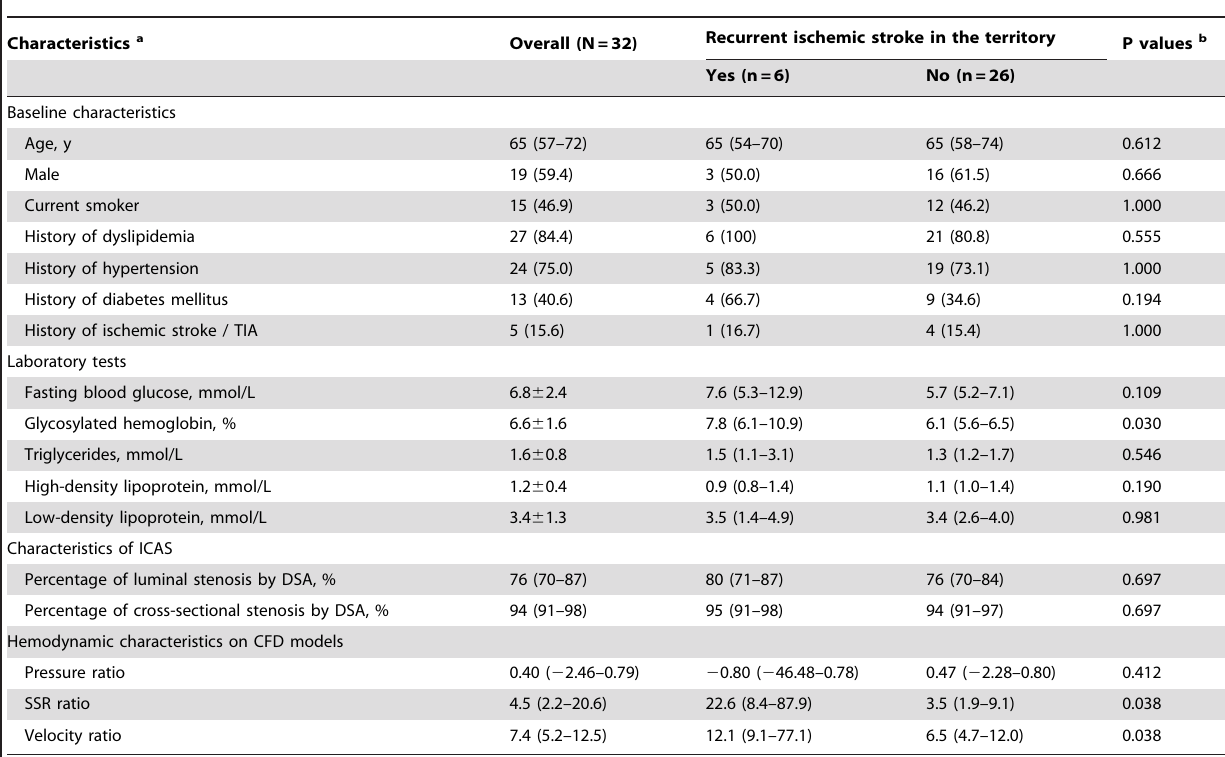
Table 1. Baseline characteristics of all patients, and patients with and without recurrent ischemic stroke in the territory of the qualifying